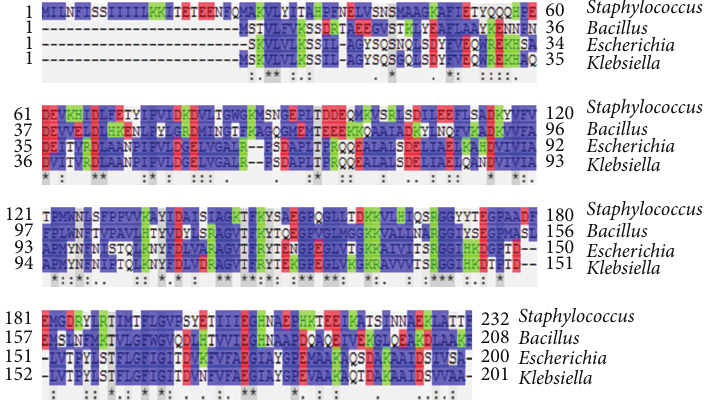
Figure 2: Multiple sequence alignment of azoreductase from Staphylococcus aureus , Bacillus subtilis , Escherichia coli, and Klebsiella sp. Amino acid residues are colored to indicate their similarity: blue = hydrophobic, red = acidic, and green = basic residues. For comparative model, the sequence identity with the template is of